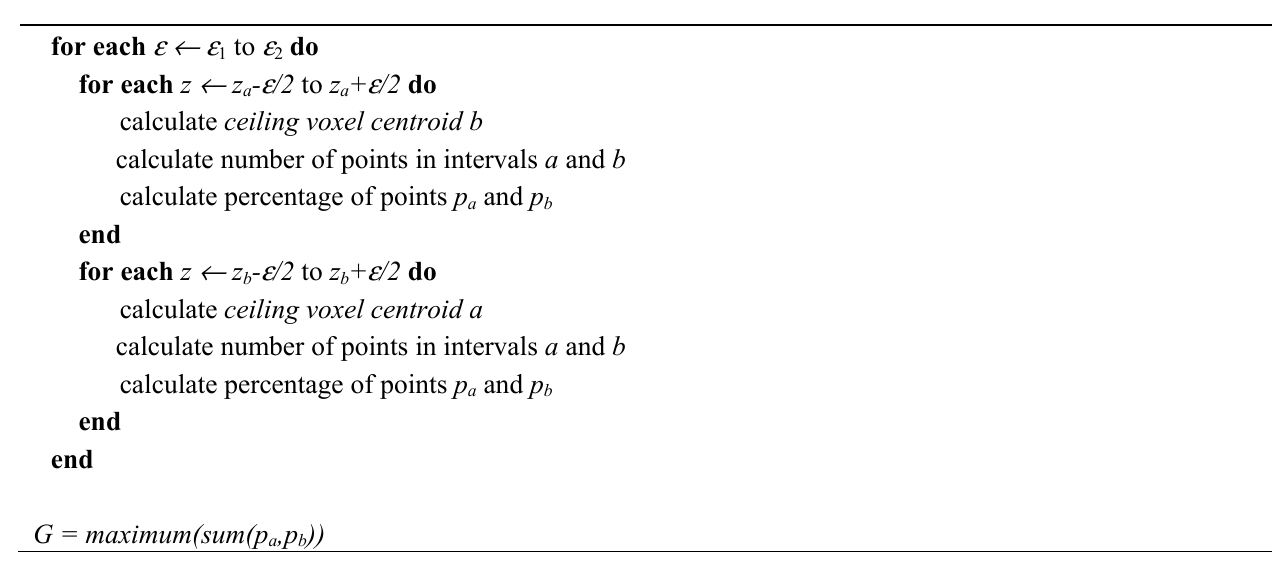
Algorithm 2. Obtaining the function G